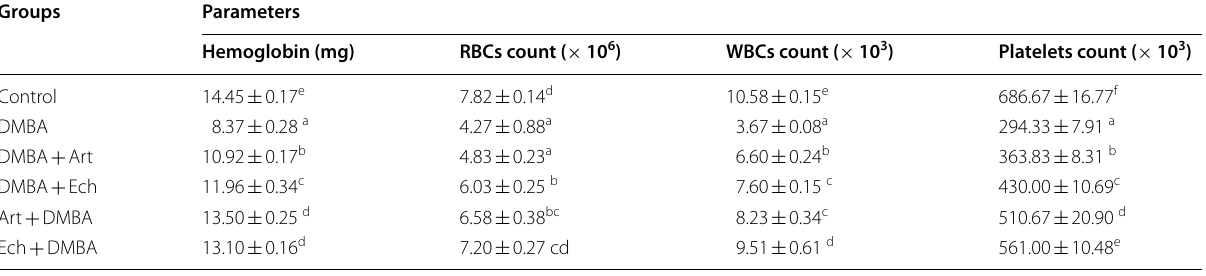
Each value represents the mean (M) Values with different superscript letters are considered significantly different ( P < 0.05) Values with same superscript letters are considered non-significantly different ( P <